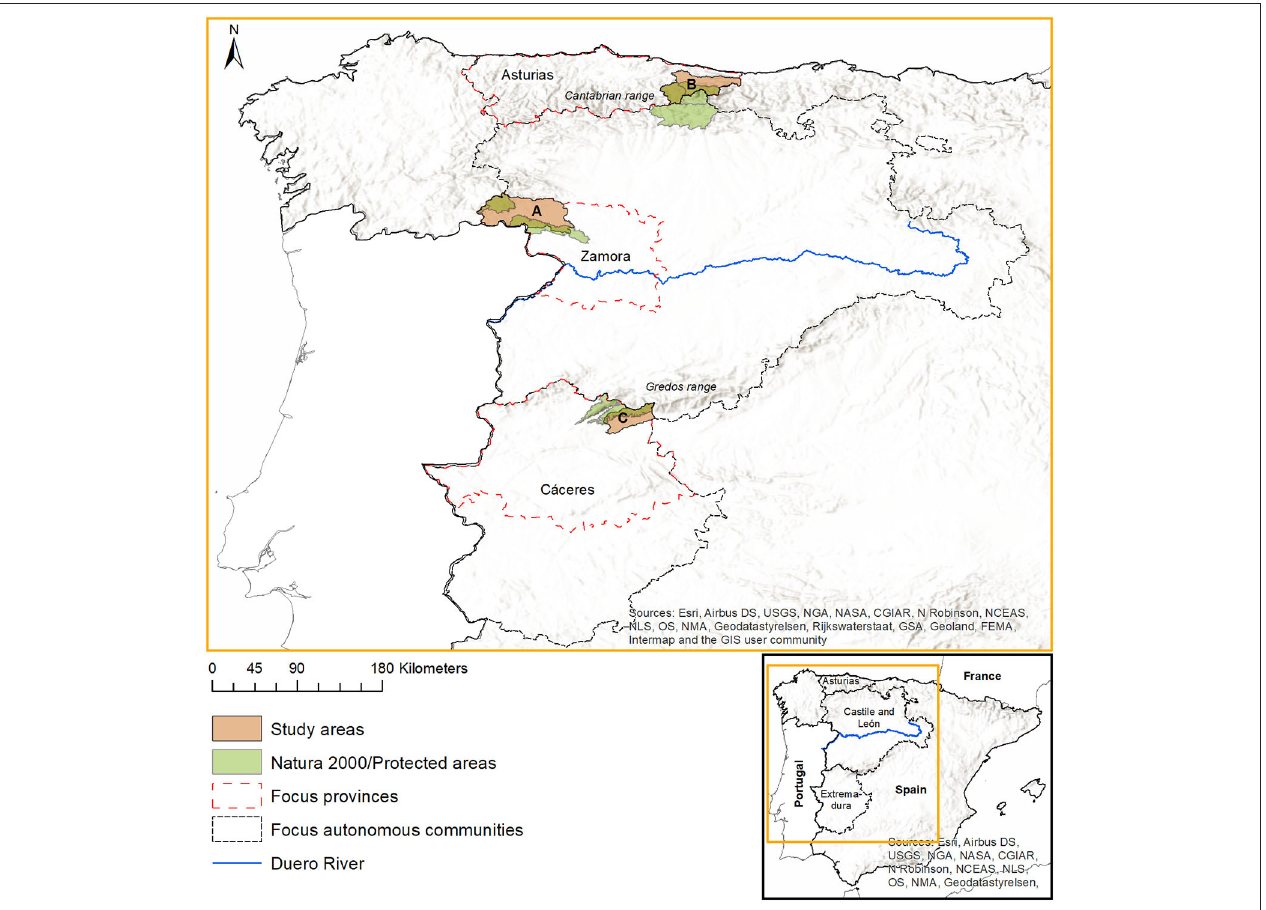
FIGURE 3 | Map of case study areas (orange), and relevant protected areas (green). Location A: Sanabria-La Carballeda, with Sanabria National park to the left and Sierra de la Culebra hunting reserve to the right. Location B : Oriente de Asturias district, with Ponga Natural Park to the left and Picos de Europa National Park to the right and center. Location C: La Vera, with the Sierra de Gredos y Valle de Jerte Natura 2000 area. Additional information about the characteristics of each location can be found in Supplementary Table 1